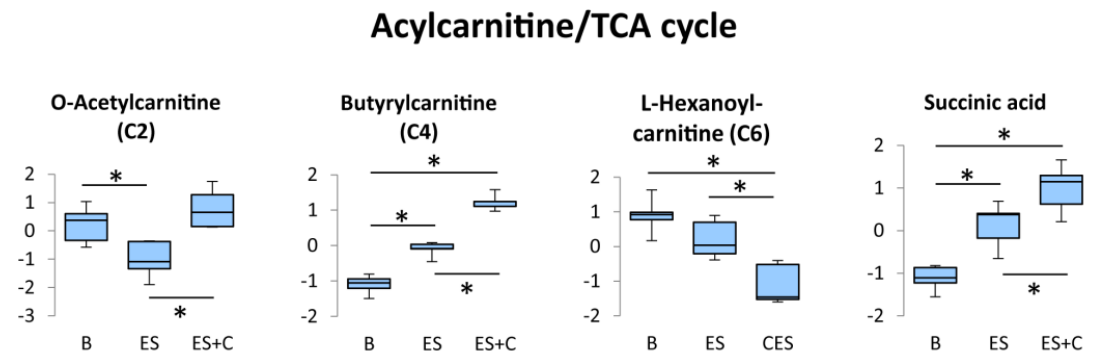
Figure 5. Box plots of the concentration variations of significantly altered metabolites in the Acylcarnitine/TCA cycle. * One-way ANOVA with Tukey’s post hoc test indicates a significant difference (FDR < 0.05) between groups.